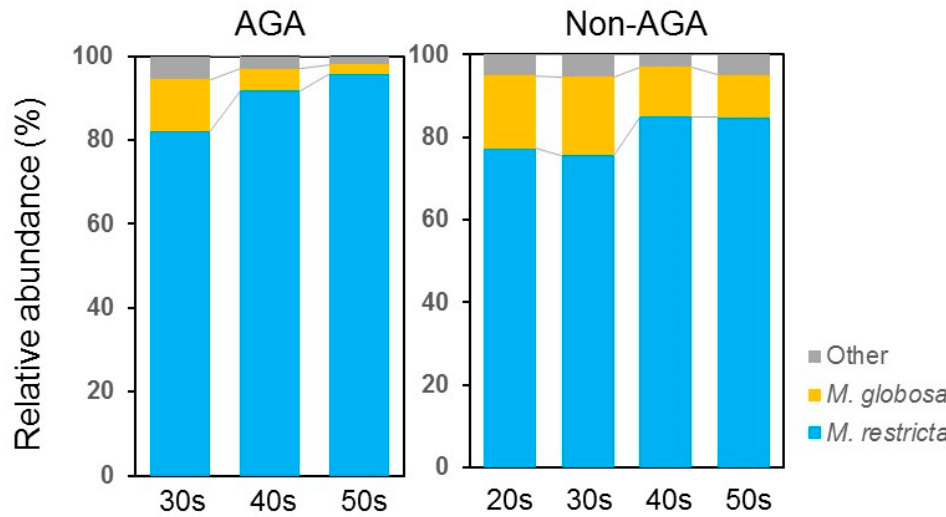
Figure 4. Ratio of Malassezia restricta to M. globosa by age. The ratio of the number of M. restricta and M. globosa reads was calculated using the number of reads for all Malassezia species as 100%.